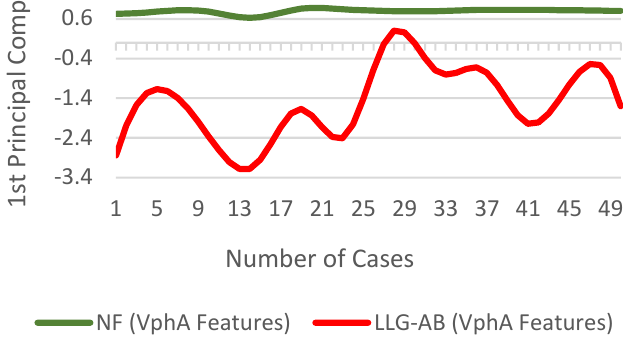
Figure 12. pc 1 of Vph A for NF and fault scenarios.